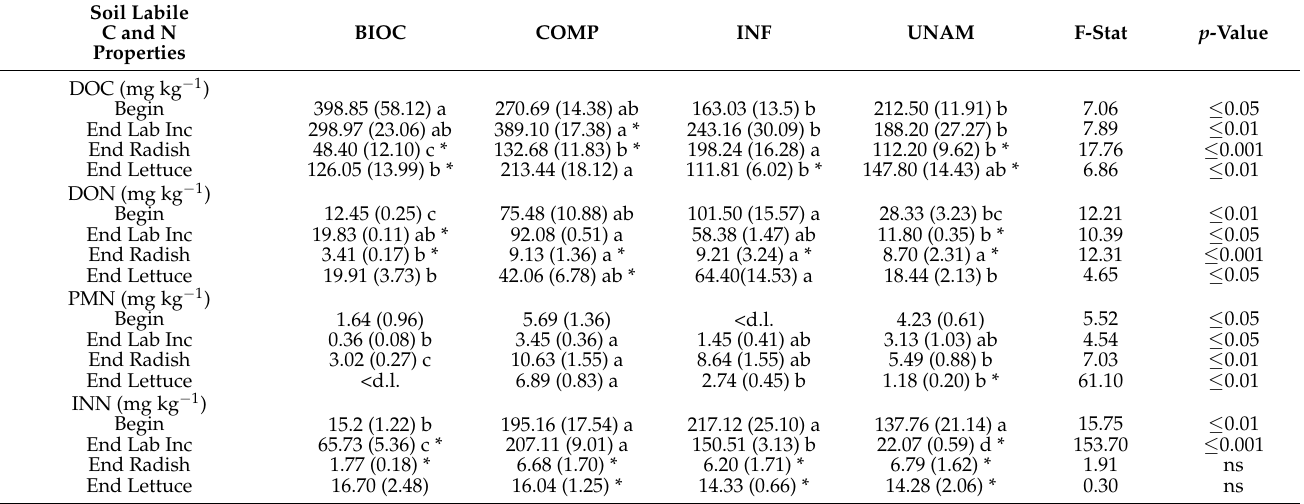
Table 4. Soil Labile carbon (C) and N (N) concentrations: dissolved organic C (DOC), dissolved organic nitrogen (N), potentially mineralizable N (PMN), and inorganic N (nitrate and ammonium; INN) in soils amended with biochar (BIOC), compost (COMP), inorganic fertilizer (INF), and from unamended control (UNAM). Values represent mean averages with standard errors in parentheses. Measurements at the beginning of the experiment before plant seeding are denoted as “Begin.” Measurements at the end of the experiment are labeled as “End.” The data are provided for individual plant species (End Radish, End Lettuce) or lab-incubated (End Lab-Inc) samples if statistical differences existed between the groups or, alternately, across all samples if there were no differences (“All”). Lowercase letters in a row indicate statistically significant differences by treatment within each group. No differences between treatments are marked as “ns.” Asterisks indicate a significant difference between Begin and End concentrations over time. Concentrations below the instrument’s detection limit are marked as “<d.l.” Statistical tests were performed using a two-way Analysis of Variance (ANOVA) or Kruskal-Wallis if data could not be normalized. Tukey HSD or Dunn’s test were used to determine treatment significance at p ≤ 0.05 at